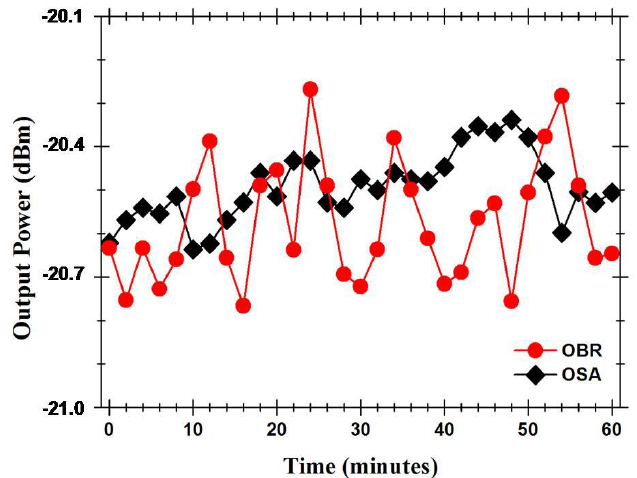
Figure 9. Output signal’s power fluctuations over time.